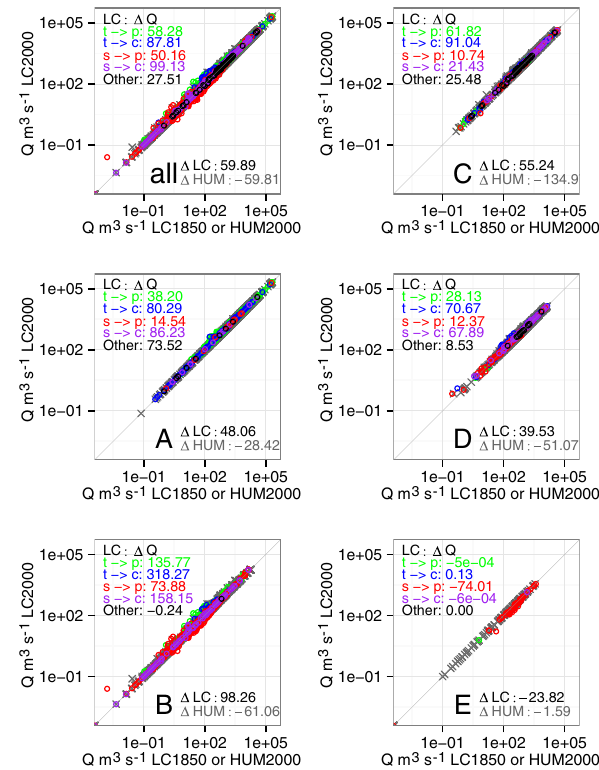
Figure 8. River discharge ( Q ) changes (in m 3 s − 1 ) per subbasin for all Köppen classes (shown in the top left of each panel) as well as per Köppen class. The axes are on a log scale. Each circle color represents a land cover change: tall to pasture (green), tall to crop (blue), short to pasture (red), short to crop (purple) or other (black, crop or pasture to short or tall natural). No circles are drawn in sub- basins where no land cover change occurs. Gray crosses represent discharge in LC2000 and HUM2000. Köppen class A is equatorial, B is arid, C is warm temperate, D is snow and E is polar climates. In each panel the top-left numbers are the average discharge change per land cover change (in m 3 s − 1 ); in the bottom right are the total land cover changes as well as the changes due to human water use. Areas and number of subbasins per land cover change are given in Table